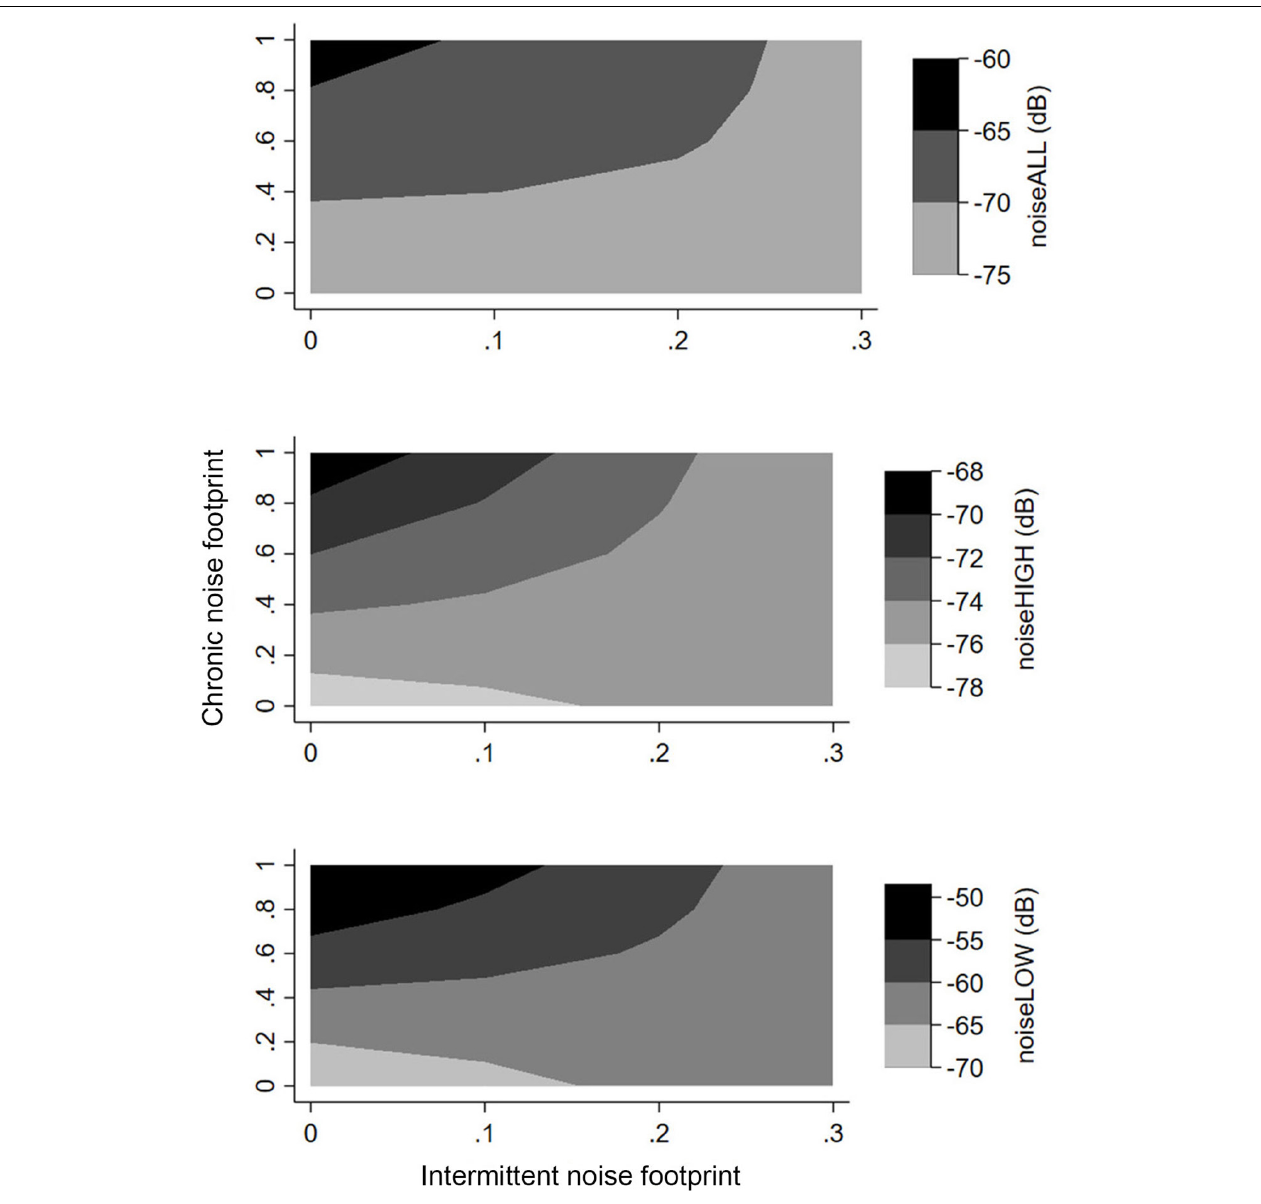
FIGURE 6 | Change in noise metrics represented in 3-D contour plots showing predicted noise level as an interactive function of proportion of area covered by footprint thought to generate chronic noise vs. proportion of area covered by footprint thought to generate intermittent noise. Graphs shows for noiseALL, noiseLOW, and